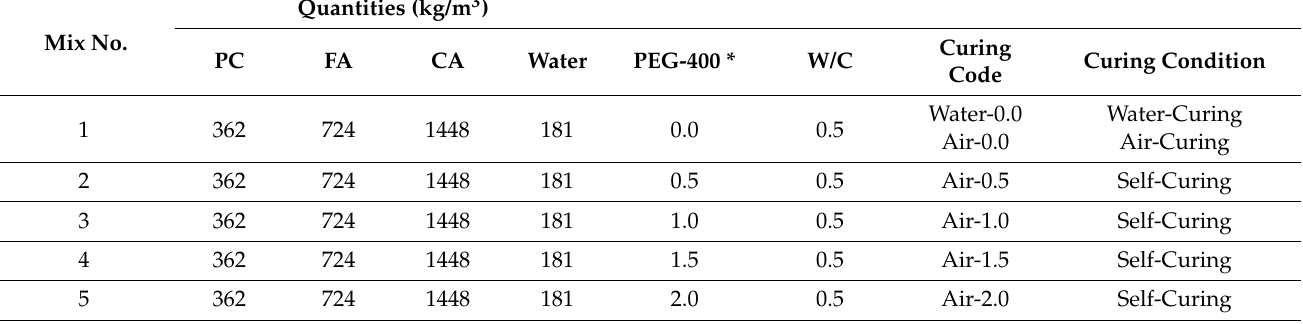
Table 5. Details of concrete